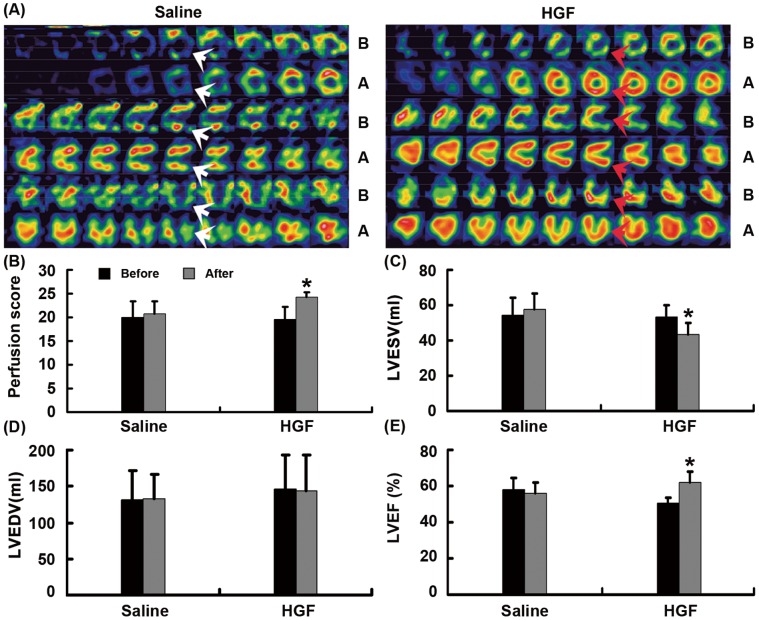
The myocardial perfusion and cardiac function.(A) Representative images of SPECT of saline (left) and HGF (right) treated porcine chronic myocardial infarct heart. Red arrows indicate regions with better myocardial perfusion; white arrows indicate regions that had similar myocardial perfusion. (B) Bar graph showing myocardial perfusion score, *P = 0.001 vs. four weeks after vector injection; (C) LVESV, *P<0.01 vs. four weeks after vector injection; (D) LVEDV, there was significant difference four weeks after the injection compared to that before the injection, P>0.05. (E) LVEF, *P<0.01 vs. four weeks after vector injection; B: before GTx; A: four weeks after GTx.